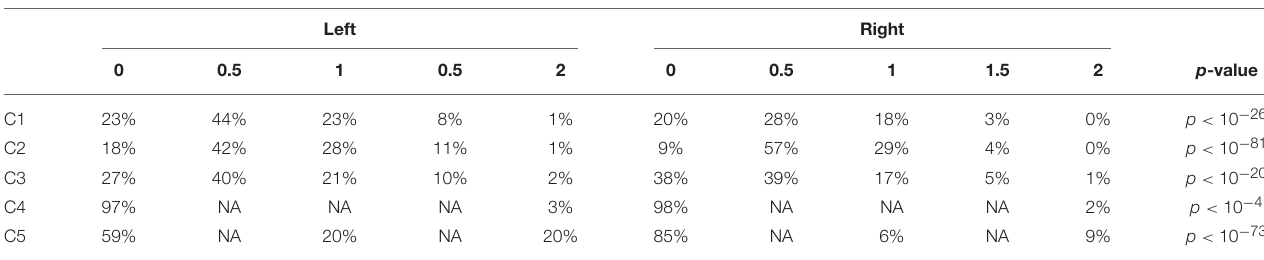
TABLE 8 | Repartition of grades for each individual criterion (in % of each criteria